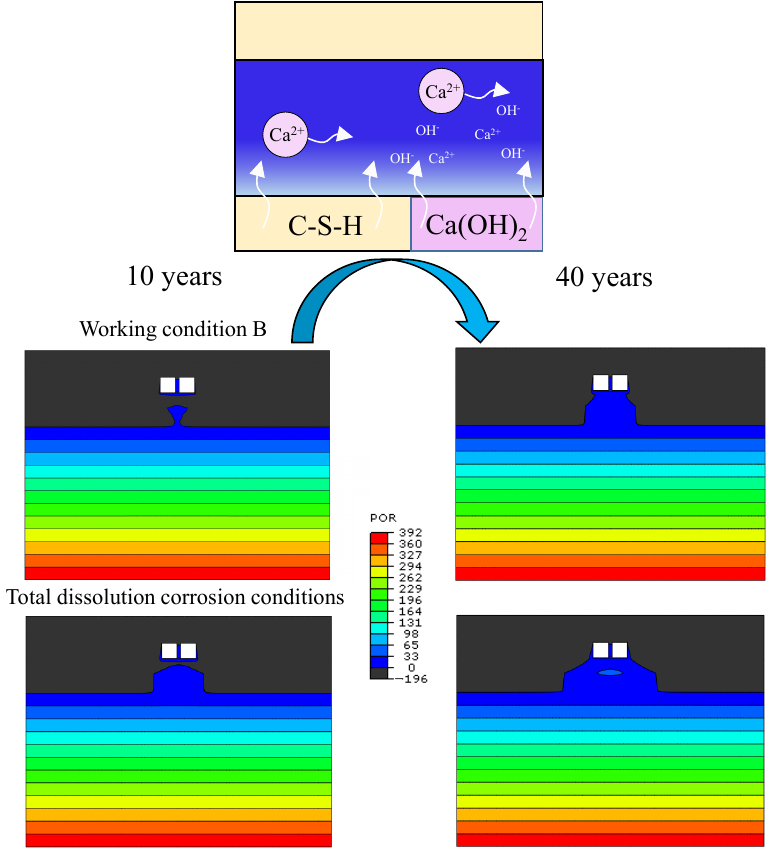
Figure 17. Variation in pore pressure value from 10 to 40 years for working condition B and total dissolution working condition (kPa).